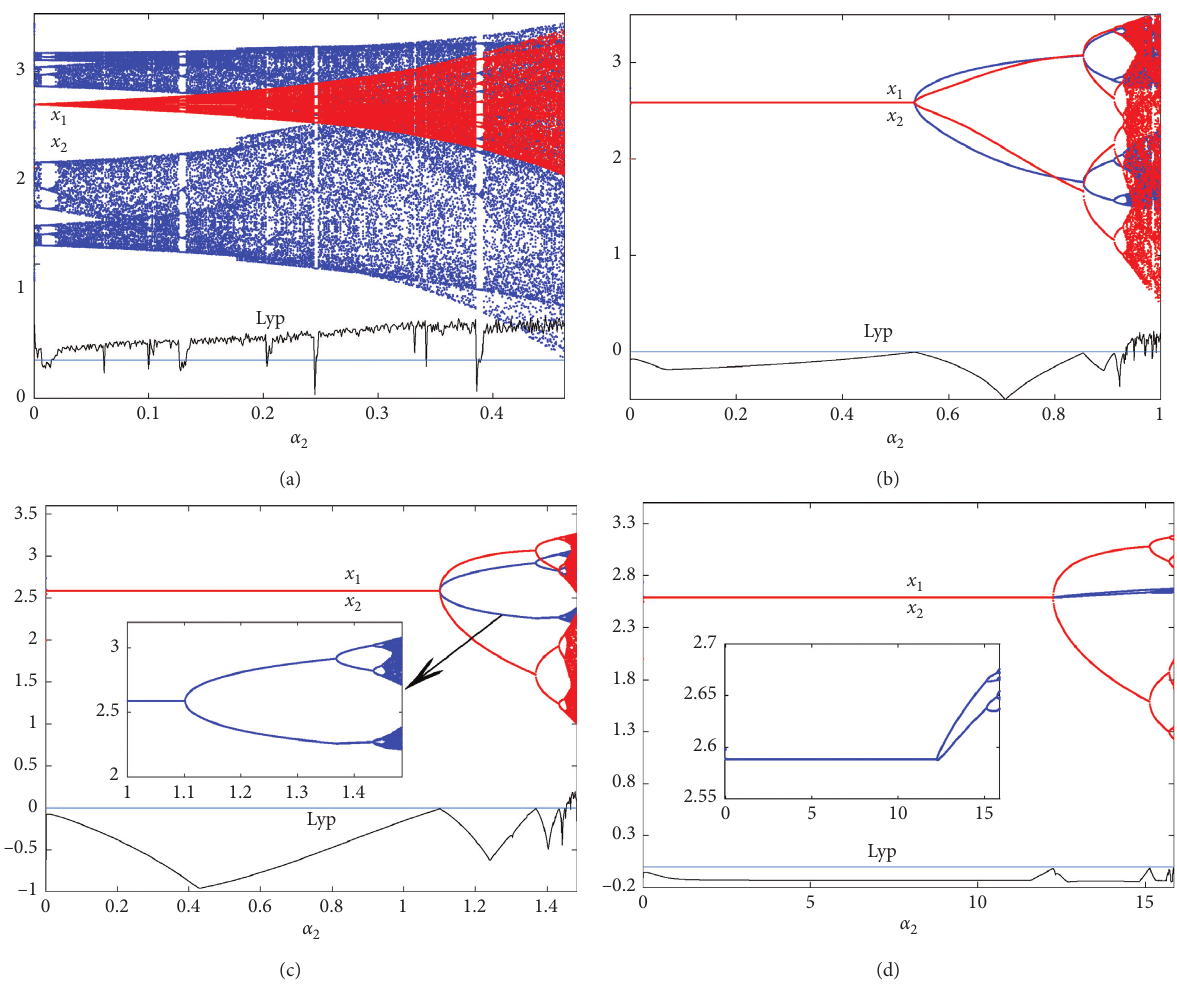
Figure 10: The bifurcation and the largest Lyapunov exponent of system (33) with respect to parameter α